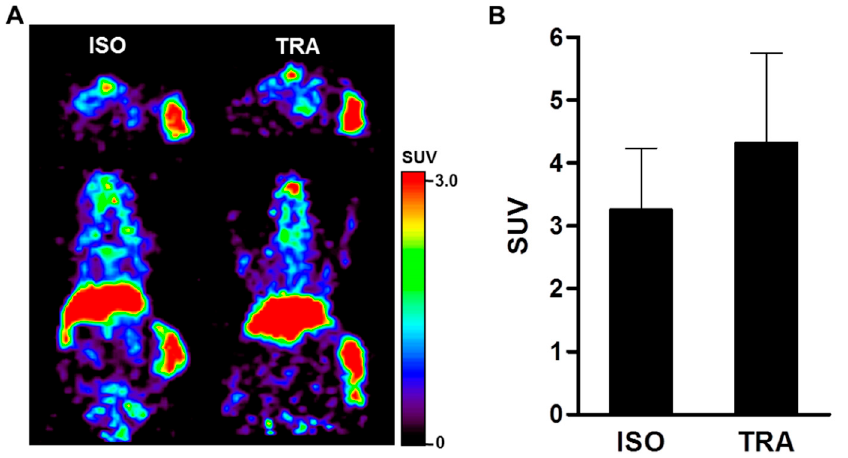
Figure 6. Immuno-PET imaging of 89 Zr-DFO-pertuzumab by trastuzumab treatment in JIMT-1 breast cancer xenograft model. ( A ) To evaluate the dynamics of HER2 expression level by treatment of isotype (ISO) and trastuzumab (TRA) using 89 Zr-DFO-pertuzumab, Immuno-PET imaging was performed in the JIMT-1 breast cancer xenograft model. Immuno-PET images were acquired 7 days after injection of 89 Zr-DFO-pertuzumab. ( B ) JIMT-1 tumor uptake of 89 Zr-DFO-pertuzumab as quantified using ASIPro display software. All images and quantitative data were expressed as a standardized uptake value (SUV).